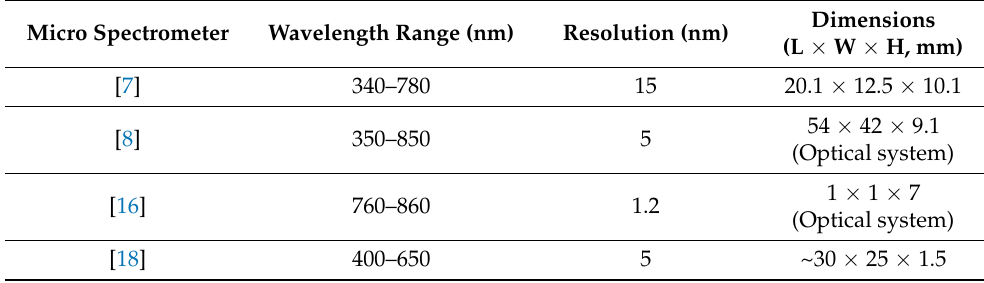
Table 1. Comparison of different micro spectrometers in terms of key